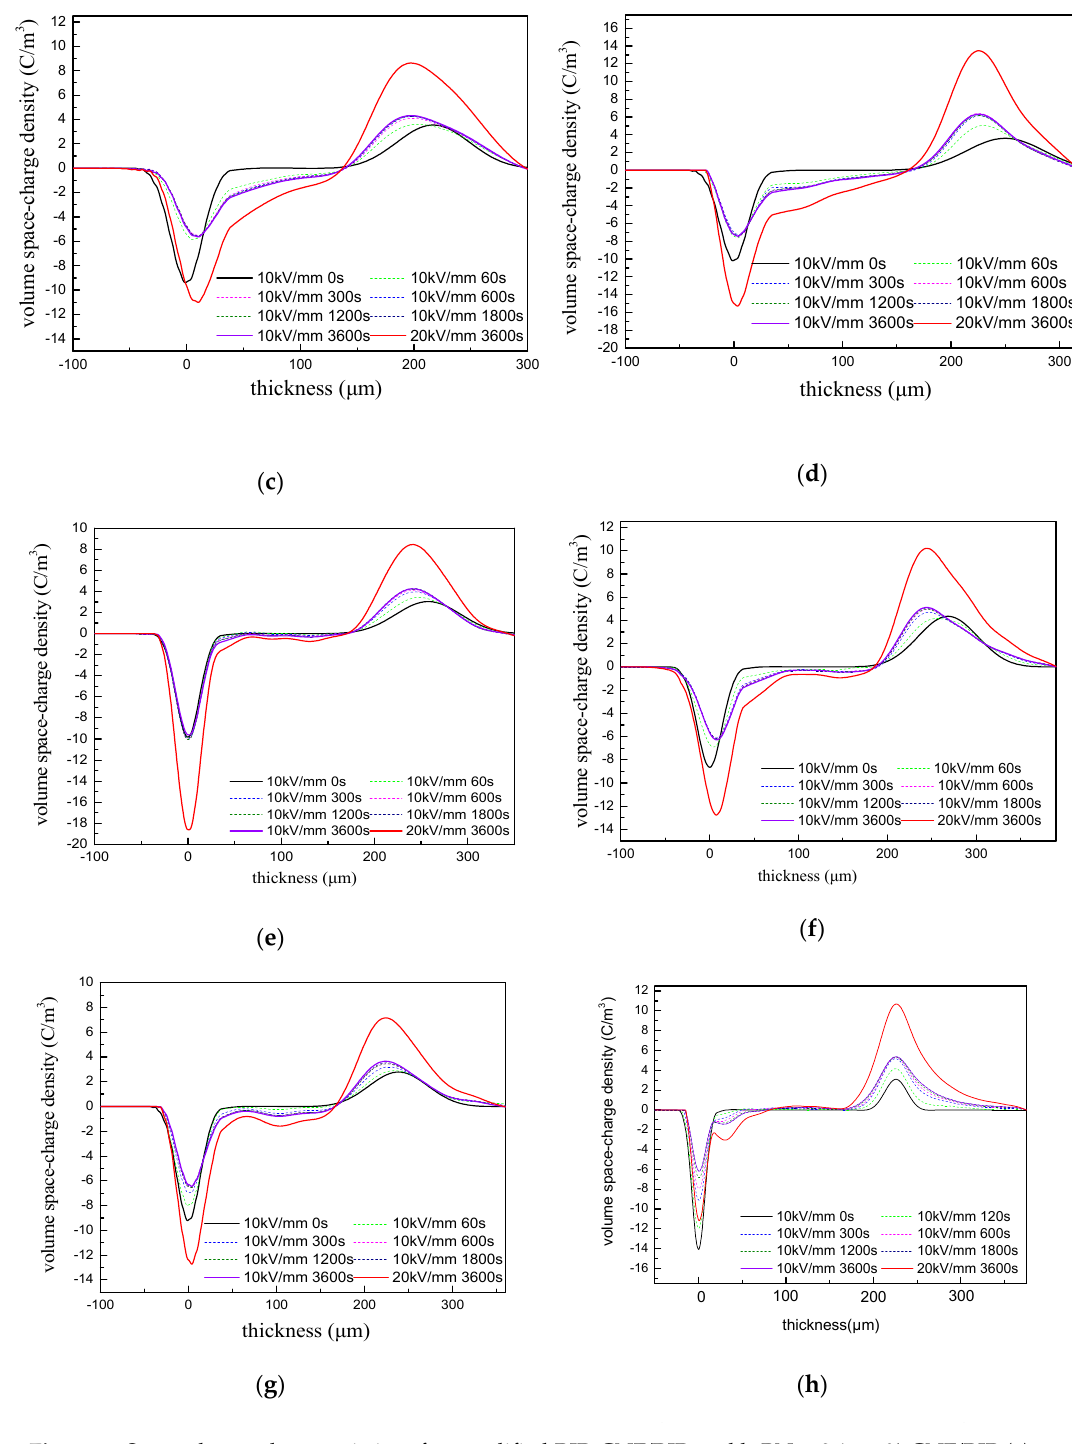
Figure 7. Space charge characteristics of unmodified RIP, CNF/RIP, and h-BN + 0.1 wt % CNF/RIP ( a ) unmodified RIP, ( b ) 0.1 wt % CNF/RIP, ( c ) 2.5 wt % h-BN + 0.1 wt % CNF/RIP, ( d ) 5 wt % h-BN + 0.1 wt % CNF/RIP, ( e ) 10 wt % h-BN + 0.1 wt % CNF/RIP, ( f ) 15 wt % h-BN + 0.1 wt % CNF/RIP, ( g ) 30 wt % h-BN + 0.1 wt % CNF/RIP and ( h ) 10 wt % h-BN/RIP.